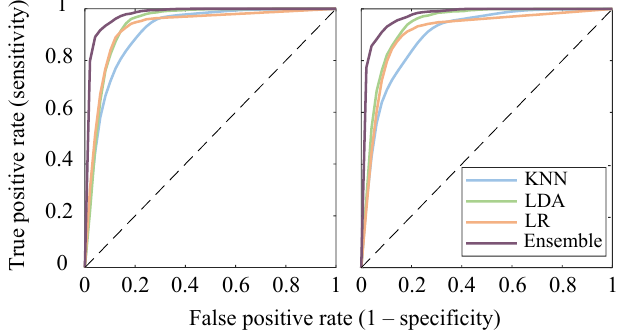
Figure 5. ROC curves of the different base and the ensemble classifiers using optimized feature subset for both validation ( left ) and testing dataset ( right